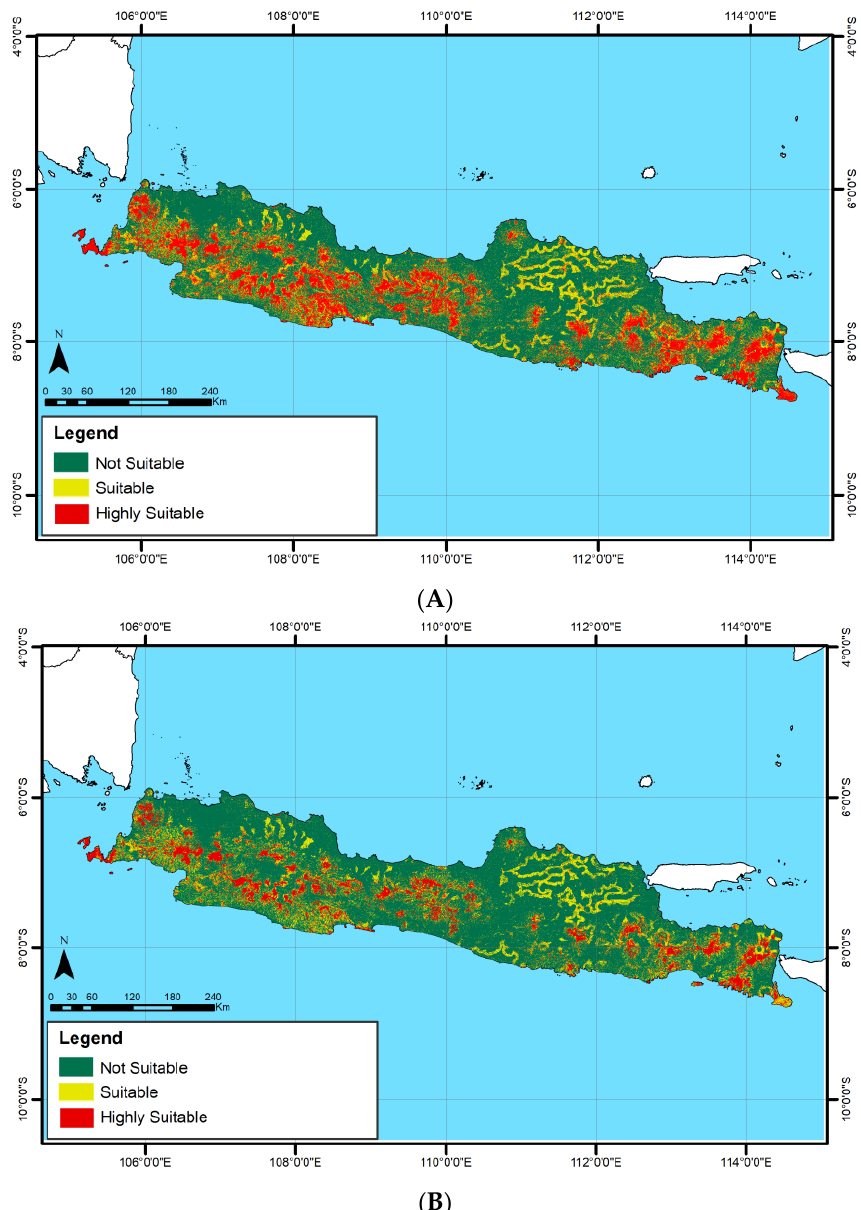
Figure 7. Javan leopard habitat suitability map: ( A ) 2000, ( B ) 2020.